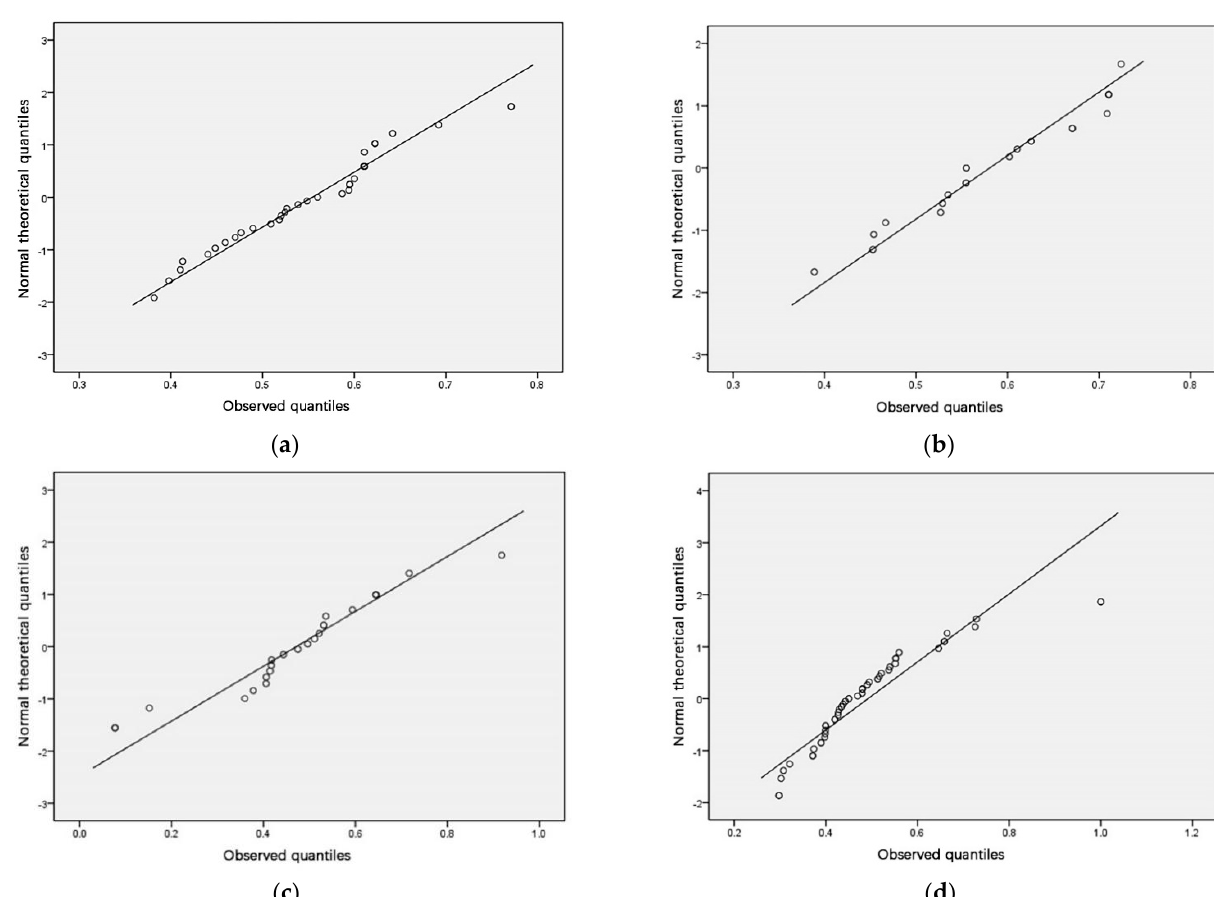
Figure 5. ( a ) Q–Q plot with the category as a factor (kindergarten), ( b ) Q–Q plot with category as a factor (primary school), ( c ) Q–Q plot with category as a factor (junior high school), ( d ) Q–Q plot with category as a factor (high school).